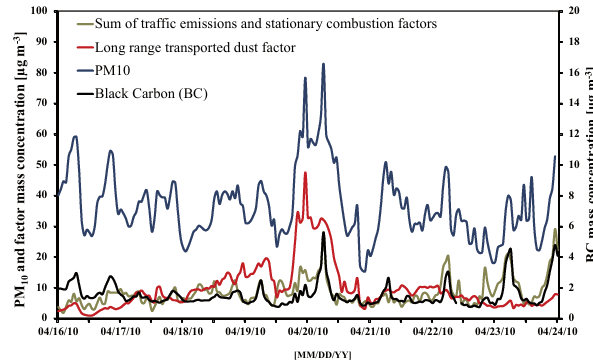
Fig. 4. Time series section of hourly average mass concentration of BC, PM 10 , long range transported dust factor and sum of traffic emissions and stationary combustion factors from 16 April 2010 to 23 April 2010 at the University of Applied Sciences in Augsburg, Germany.